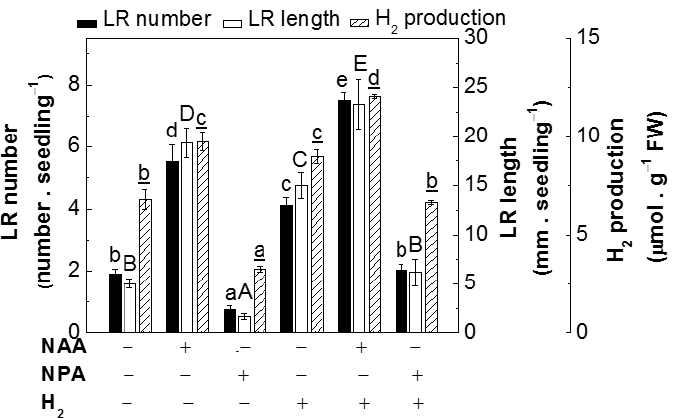
Figure 2. NAA- and NPA-regulated lateral root formation and H 2 production were regulated by exogenous H 2 . 3-day-old tomato seedlings were incubated with solutions containing 200 nM NAA, 500 nM NPA, and 0.39 mM H 2 , alone or the combination treatments. The number of emerged LRs (>1 mm) per seedling and LR length were calculated after 3-day of treatment ( n = 60). The H 2 production in roots was determined after 6-h treatment ( n = 5). Distilled water was used for the control (Con) treatment. Data are the means ± SE of three independent experiments with at least three replicates for each. Within each set of experiments, bars denoted by the same letter did not differ significantly at the p < 0.05 level according to Duncan’s multiple range test.